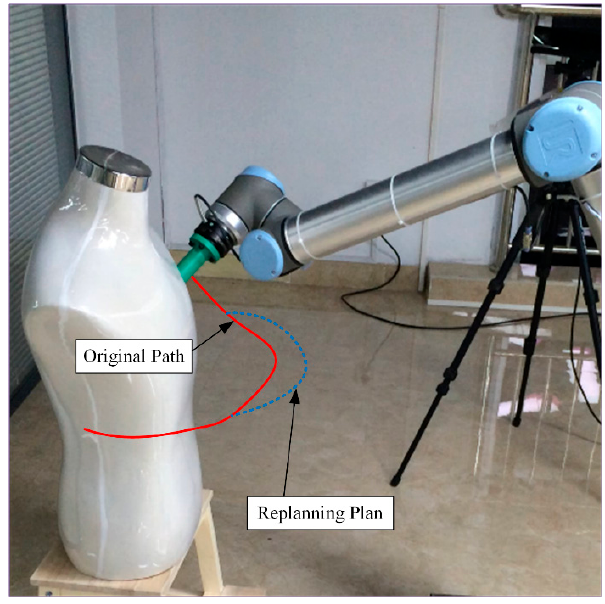
Figure 11. Replanned trajectory during the process of dynamic obstacle avoidance.